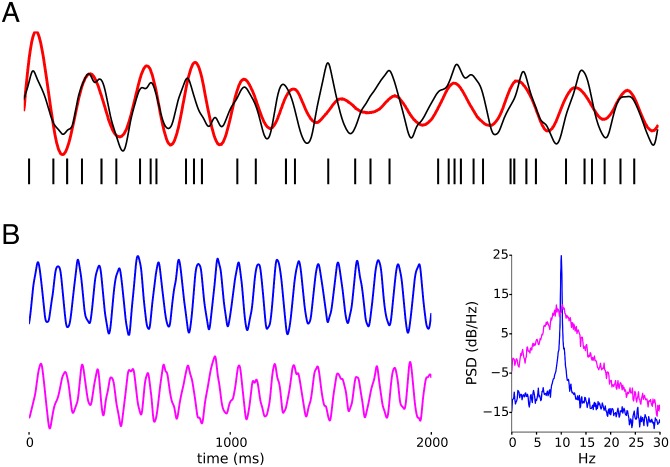
Regular and irregular oscillations.A) LOST infers (red) the oscillatory modulation (black), if any, underlying the spikes (vertical ticks) in a spike train, using only the spiking data. The oscillation amplitude stabilizes after the first few spikes are observed. B) We refer to spectrally narrow (wide) oscillations as regular (irregular), shown by the blue (pink) oscillation with OCV = 0.02 (0.22). The correlation between the current and past phase decays slowly (quickly) as a function of lag in regular (irregular) oscillations.